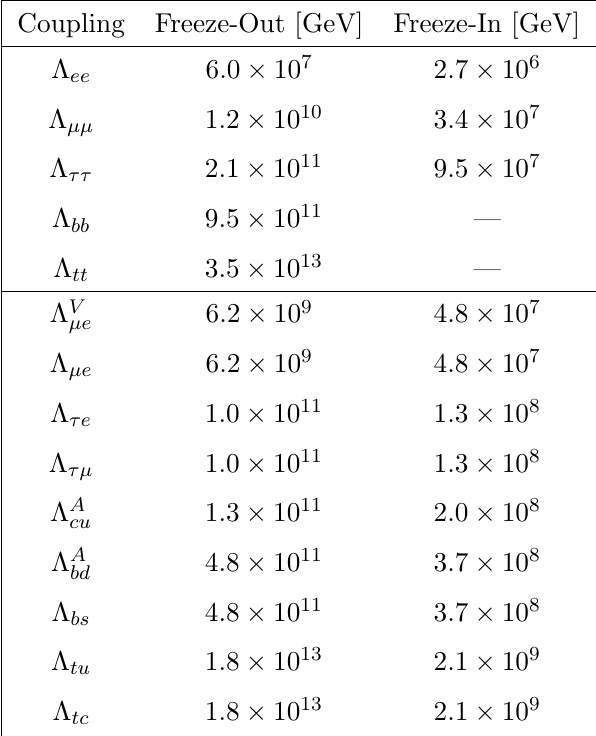
10 10 GeV and freeze-in (cid:25)